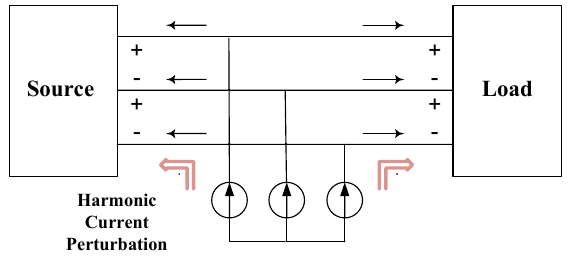
Figure 1. Current perturbation injection in the shunt